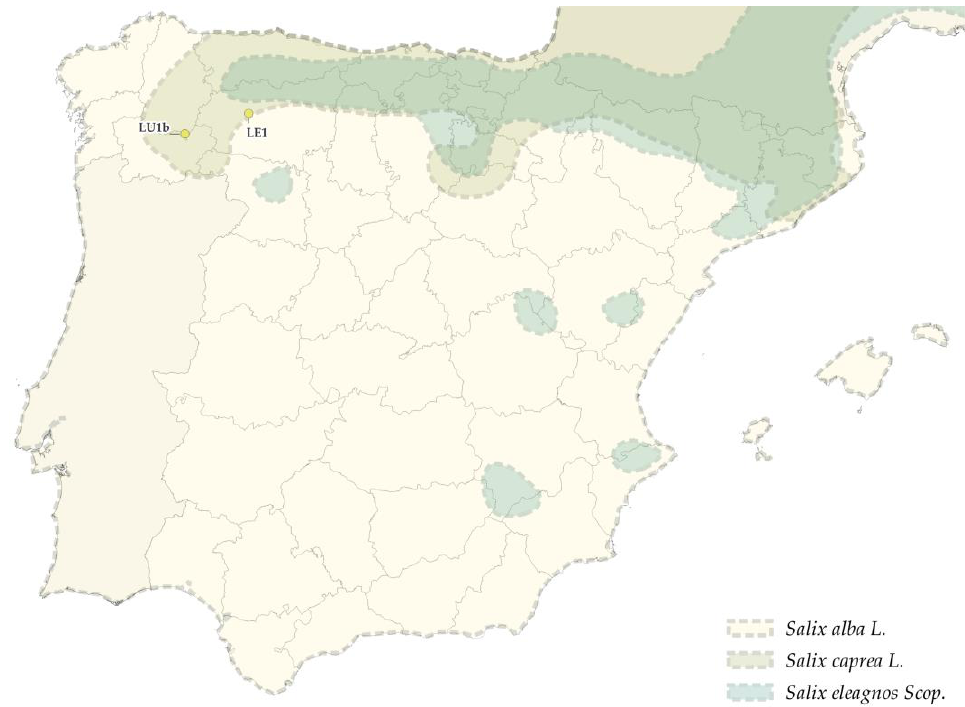
Figure 13. Distribution map of the species Salix alba L., Salix caprea L., and Salis eleagnos Scop. and